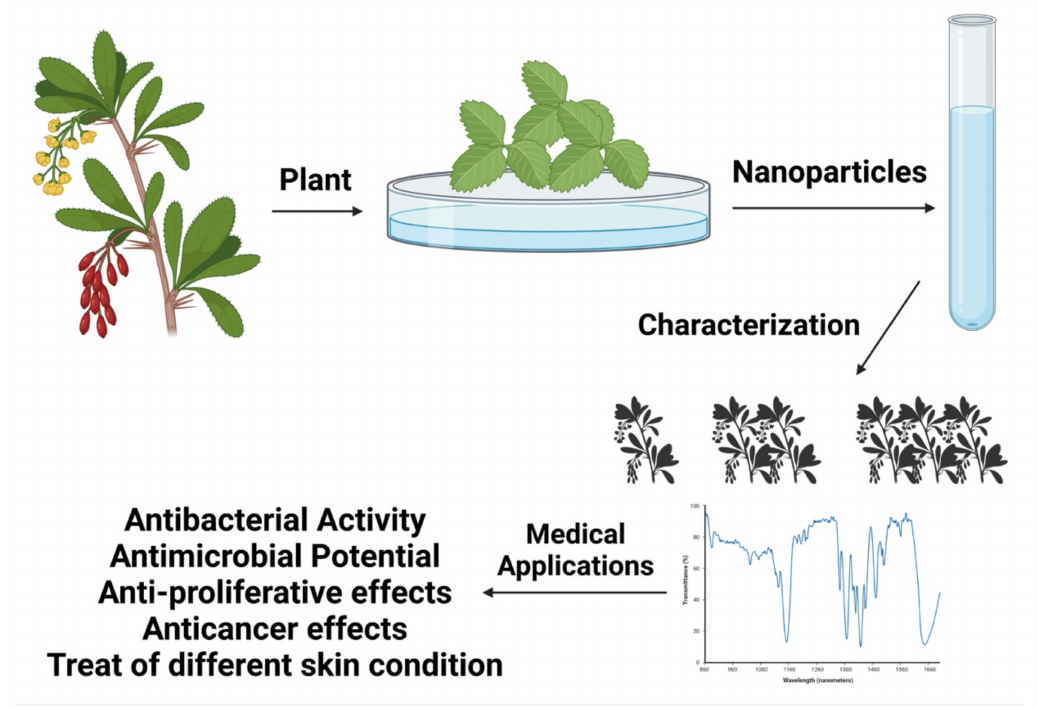
Figure 9. An illustration of the green synthesis and use of